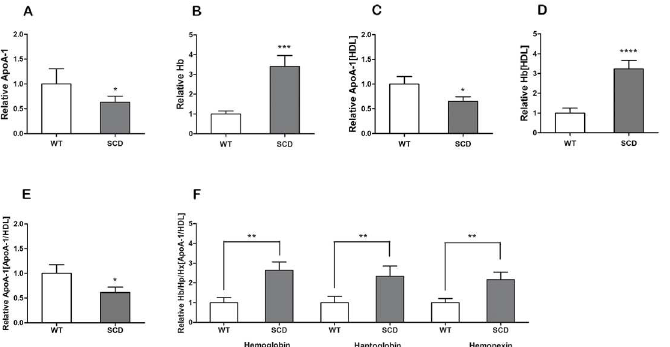
Fig 3. Hemoglobin (Hb), haptoglobin (Hp) and hemopexin (Hx) content is increased in ApoA-1 particles of HDL in SCD mice vs. wild-type (WT) mice. (A,B) ApoA-1 and Hb levels, respectively, in the plasma of SCD mice (n = 8) and WT mice (n = 8). (C,D) ApoA-1 and Hb levels, respectively, in HDL measured by sandwich ELISA. (E) Immunoprecipitationwas used to obtain the ApoA-1 particles.